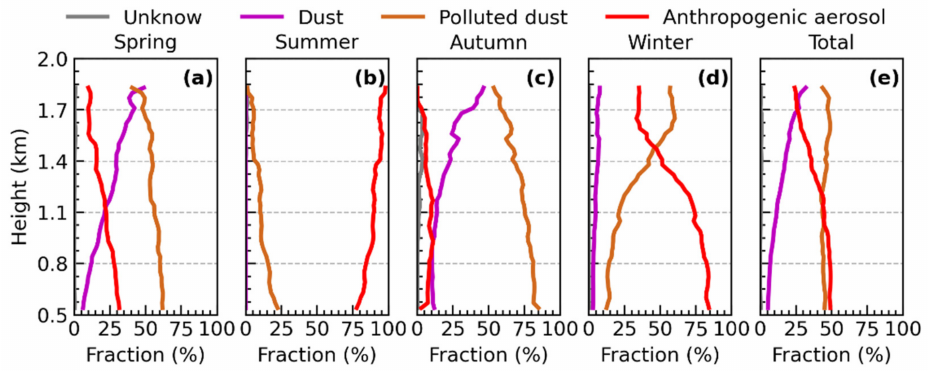
Figure 12. The relative contributions of key aerosol types in ( a ) spring, ( b ) summer, ( c ) autumn, ( d ) winter, and ( e ) the whole year in BTH